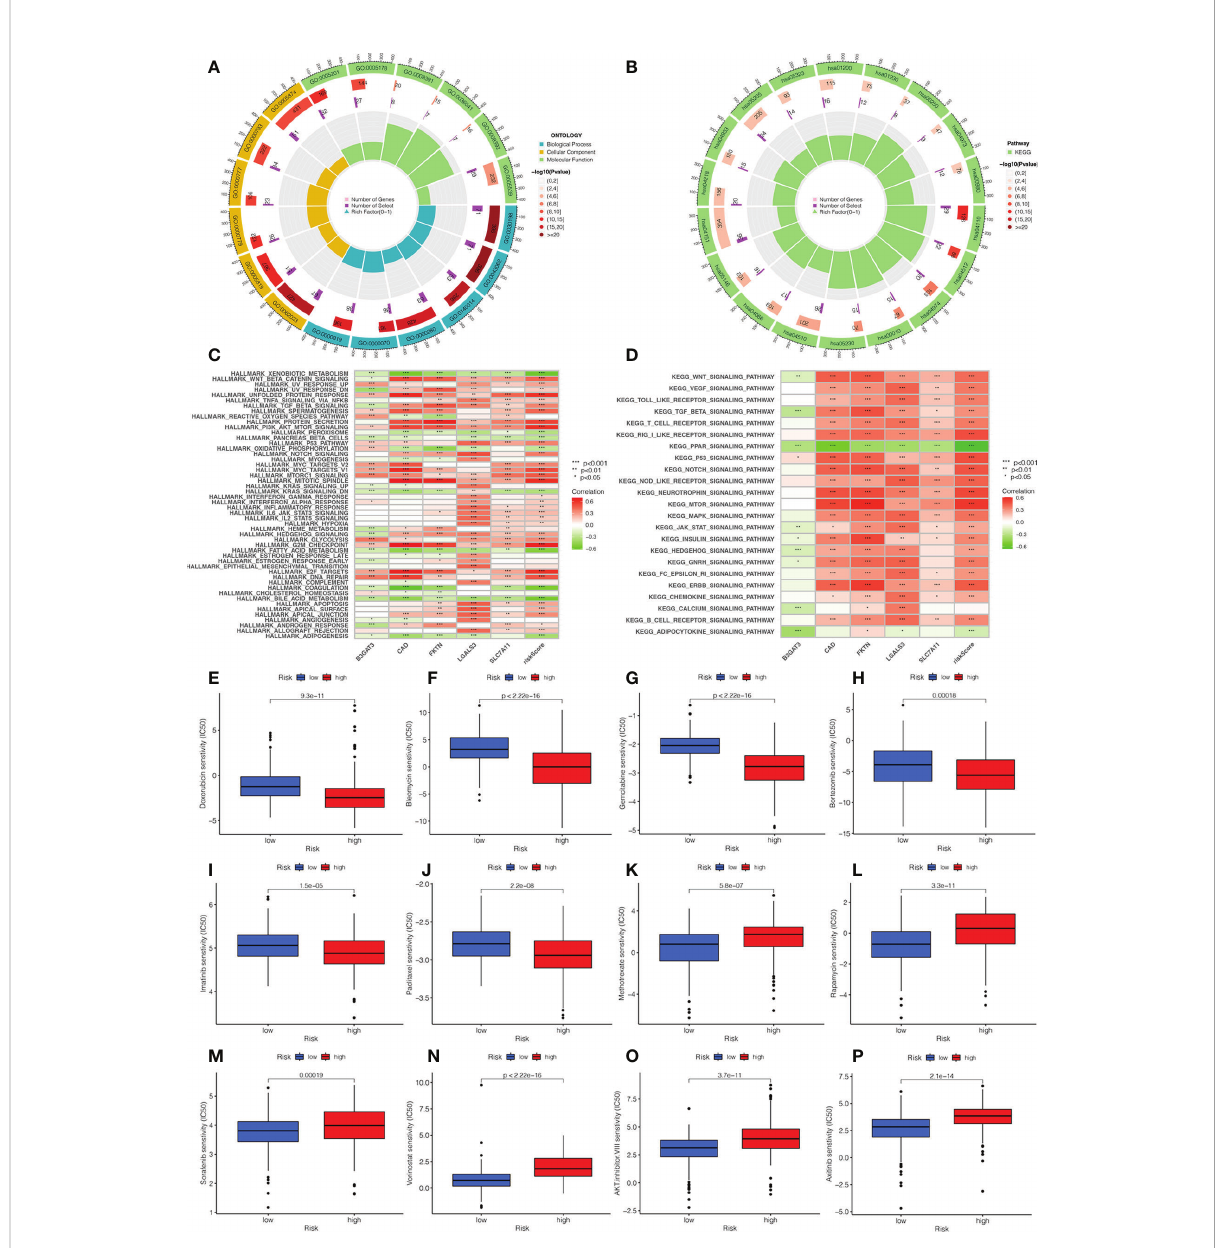
FIGURE 7 Analysis of functional enrichment and application of the signature in drug sensitivity. (A) The GO analysis by a chordal graph. (B) The KEGG analysis between low- and high-risk groups by a chordal graph. (C) The hallmark processes by GSVA analysis in fi ve genes by GSVA analysis. (D) The KEGG signaling pathway by GSVA analysis. The association between drug sensitivity and low- and high-risk groups: (E) Doxorubicin. (F) Bleomycin. (G) Gemcitabine. (H) Bortezomib. (I) Imatinib. (J) Paclitaxel. (K) Methotrexate. (L) Rapamycin. (M) Sorafenib. (N) Vorinostat. (O) AKT.inhibitor VIII. (P)